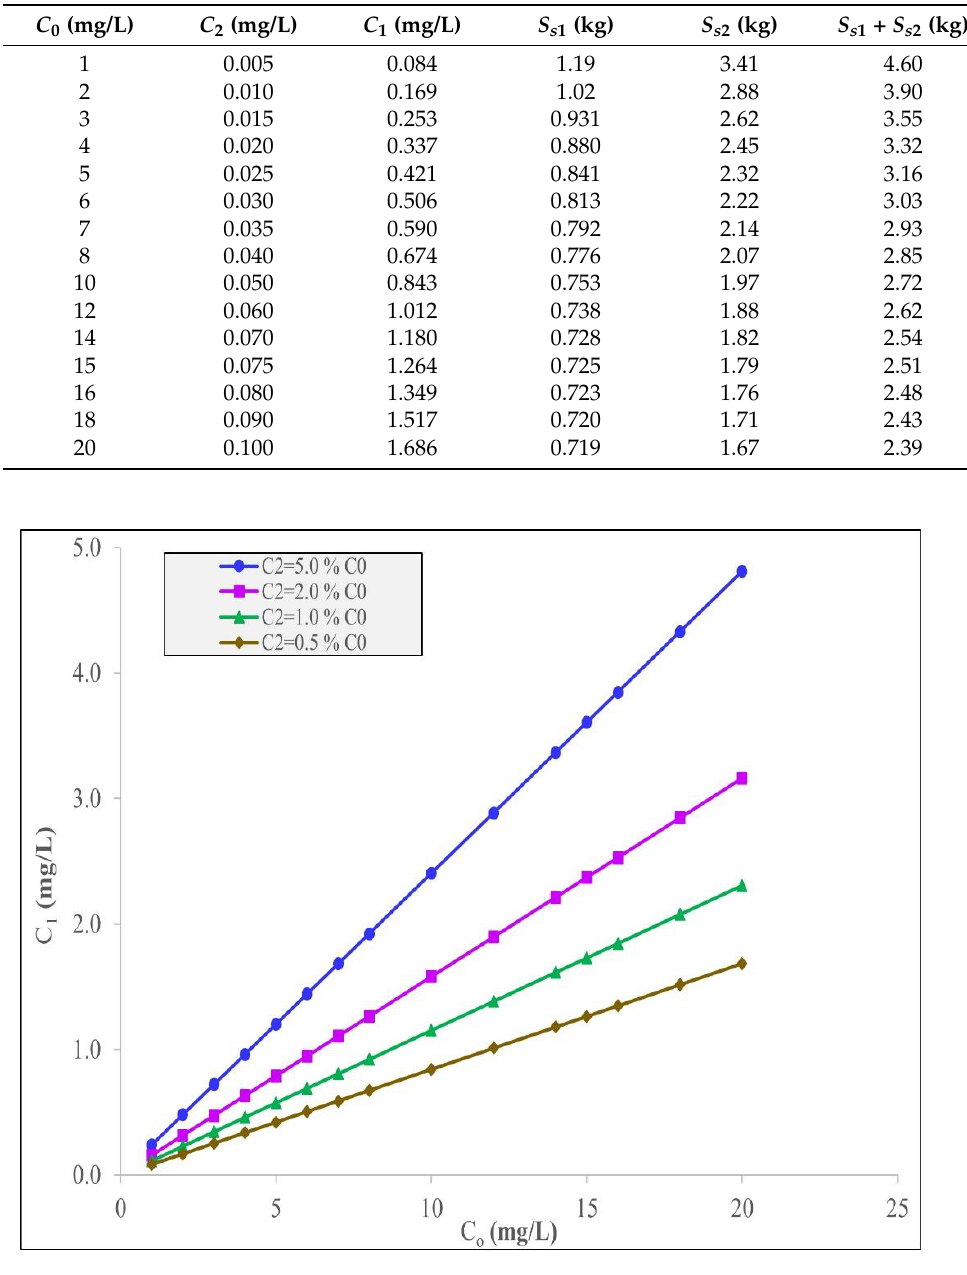
Figure 3. Interstage concentrations, C 1 , to remove different fixed% C 0 IBU using the Langmuir – Freundlich model.